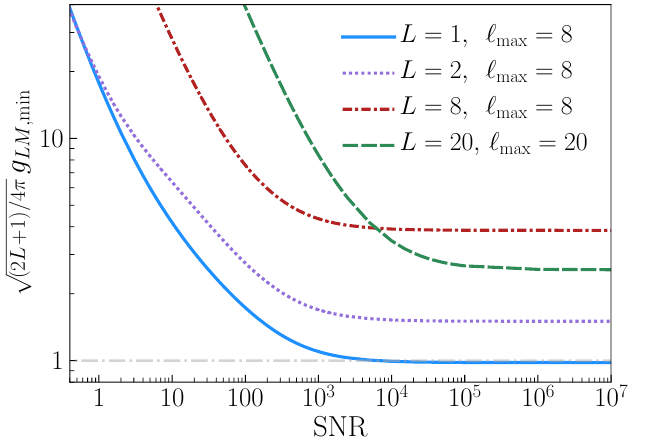
FIG. 2. The smallest detectable anisotropy coefficient g LM , for L = { 1 , 2 , 8 , 20 } , as a function of the total SNR with which the isotropic GW signal is detected. Results are provided for (cid:96) max = { 8 , 8 , 8 , 20 } respectively for the different L .